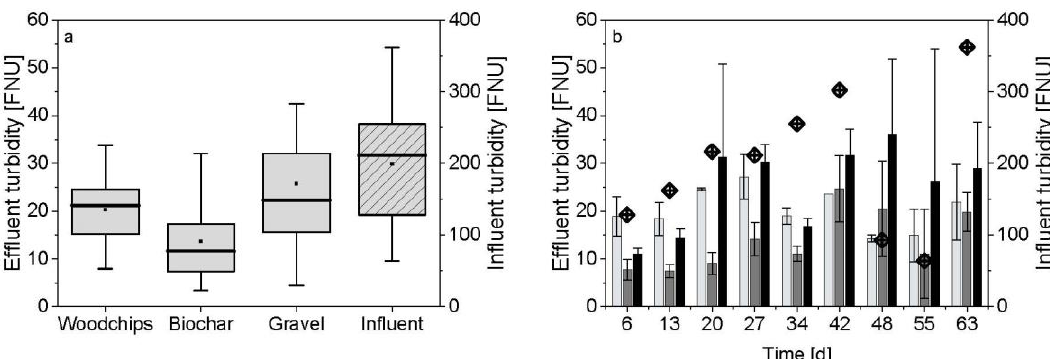
Figure 2. ( a ) Box-plots of the effluent and influent turbidity of different filter materials. Whiskers represent 1.5 interquartile ranges, and average values are represented as black squares. ( b ) Average turbidity of gravel (black), biochar (grey), and woodchips (light grey) filter effluent and influent (diamond with cross) over time. Error bars represent standard deviation.